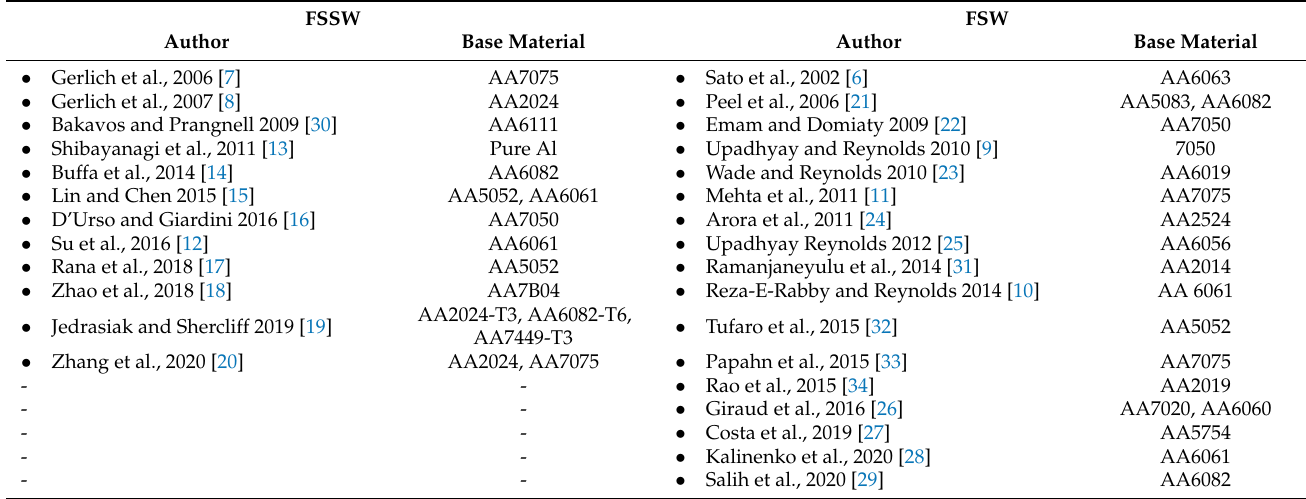
Table 1. Experimental works that analyse the influence of the processing parameters on the welding thermal cycles registered during the FSSW and FSW processes of aluminium alloys.